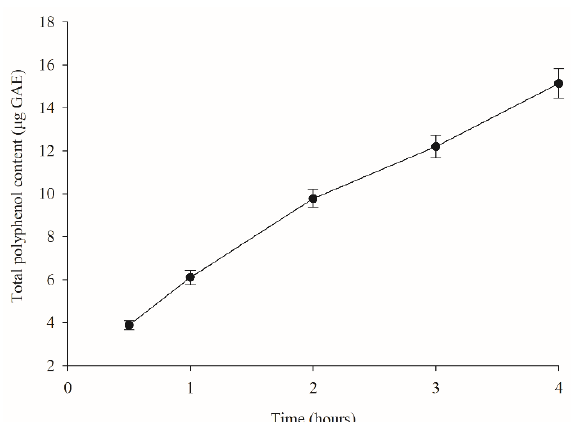
Figure 5. Total polyphenol content (TPC) released in distilled water from Mesona chinensis beads (MCB) at 0.5, 1, 2, 3, and 4 h. Data are expressed as mean ± SEM ( n =